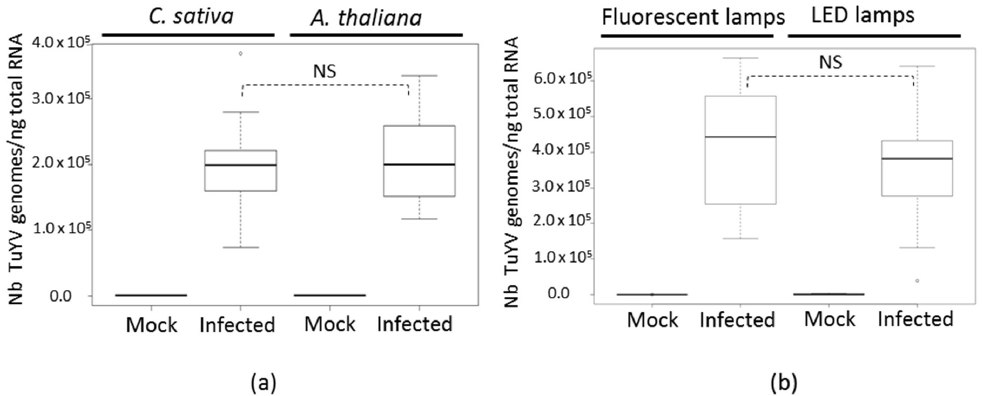
Figure 2. Analysis of TuYV accumulation by quantitative real-time reverse transcriptase-polymerase chain reaction (RT-PCR) in non-infected and infected C. sativa and A. thaliana . ( a ) Virus titer was analyzed at 20 ( C. sativa , n = 3 mock-inoculated and n = 11 TuYV-infected plants) and 19 ( A. thaliana , n = 3 mock-inoculated and n = 6 TuYV-infected plants) days post-inoculation. In this assay, plants were grown under fluorescent lights. ( b ) Virus titer was analyzed four weeks post-inoculation in A. thaliana cultivated under fluorescent lamps ( n = 7 mock-inoculated and n = 12 TuYV-infected plants) or LED lamps ( n = 3 mock-inoculated and n = 10 TuYV-infected plants). Error bars represent means ± SE for the replicates. Statistical significance of the differences between infected plants was tested using a Mann-Whitney U test. NS = not significant = p -value > 0.05.